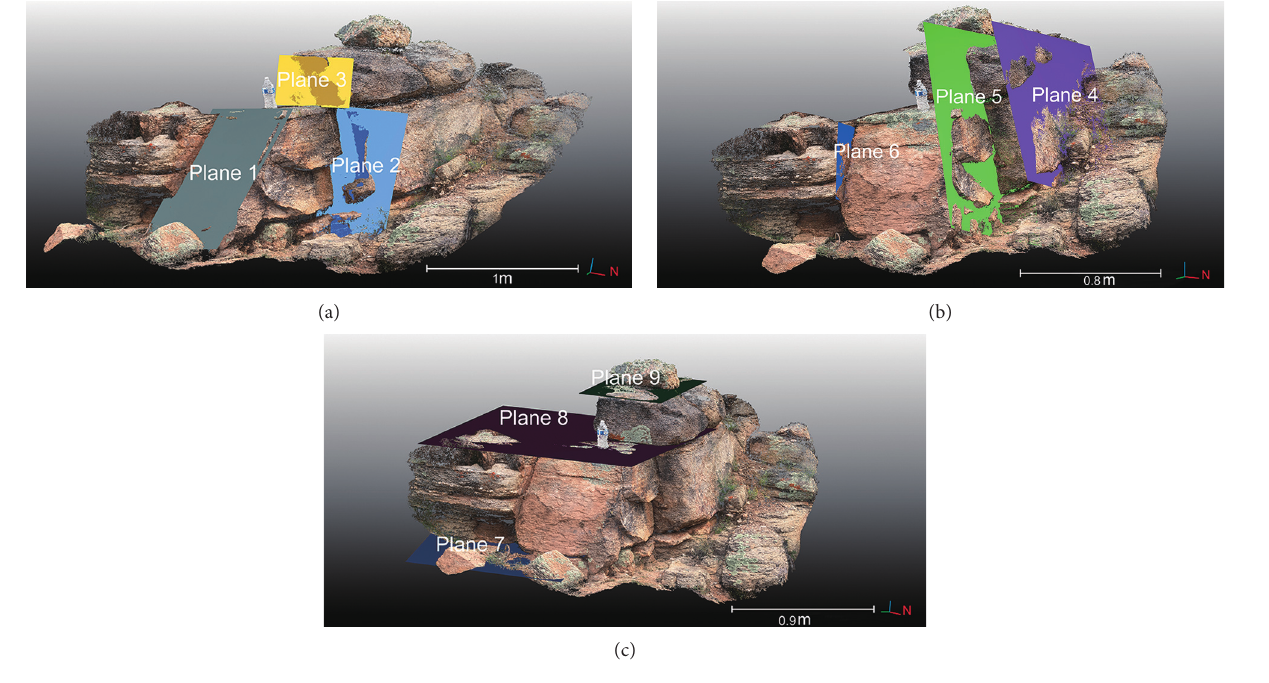
Figure 9: Joint sets of sample rock blocks. (a) Joint set 1. (b) Joint set 2. (c) Joint set